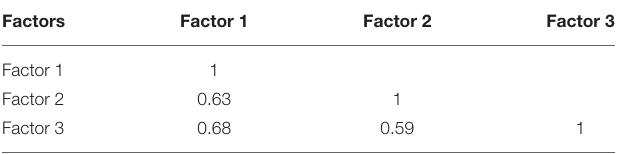
TABLE 3 | Correlation matrix of the 3 factor analysis.